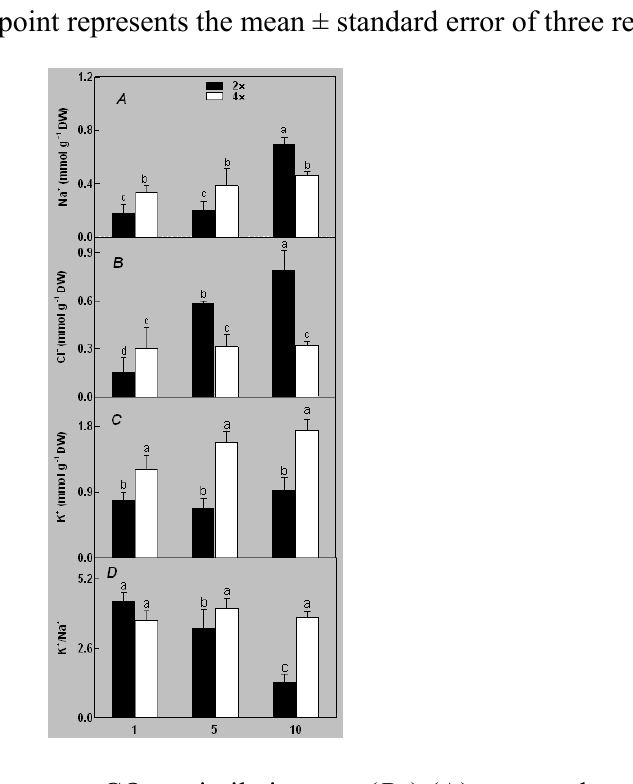
assimilation rate ( Pn ) ( A ), stomatal conductance Figure 5. Effects of salt stress on net CO 2 ( Gs ) ( B ), and intercellular CO concentration ( Ci ) ( C ) in the leaves of Robinia pseudoacacia 2 diploid (2×) (black bars) and tetraploid (4×) (white bars) plants growing under salt stress. Values followed by different letters are significantly different from each other at p < 0 . 05 according to Duncan’s method. Each data point represents the mean ± standard error of three